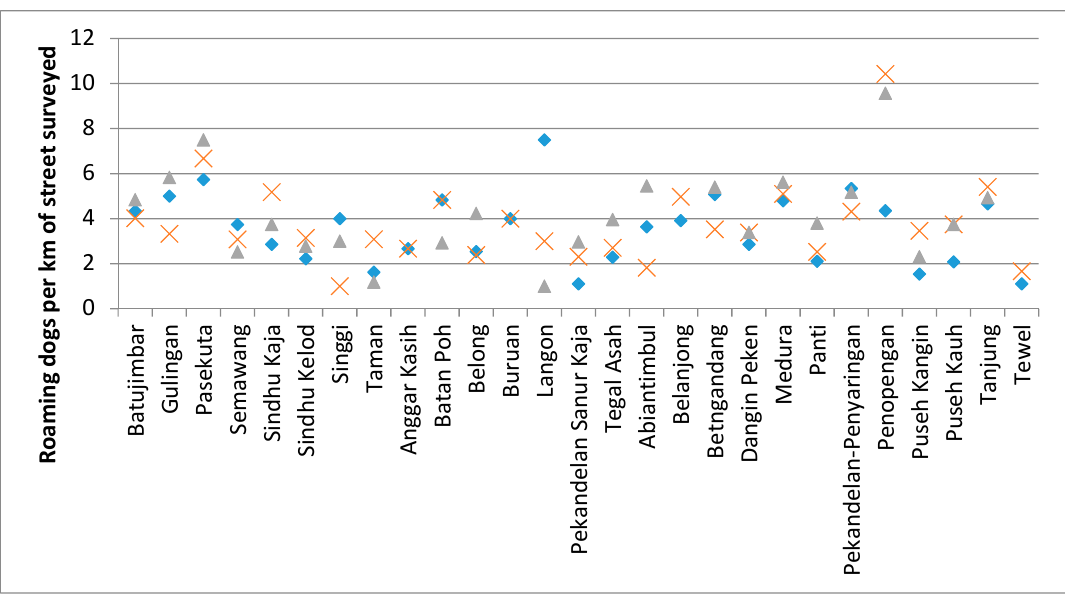
Figure 15. The number of roaming dogs per km of street surveyed is shown for each banjar . The three icons represent the density on each of the three replicate surveys along the same banjar route; blue diamond on day 1, green triangle on day 2, and red cross on day 3.